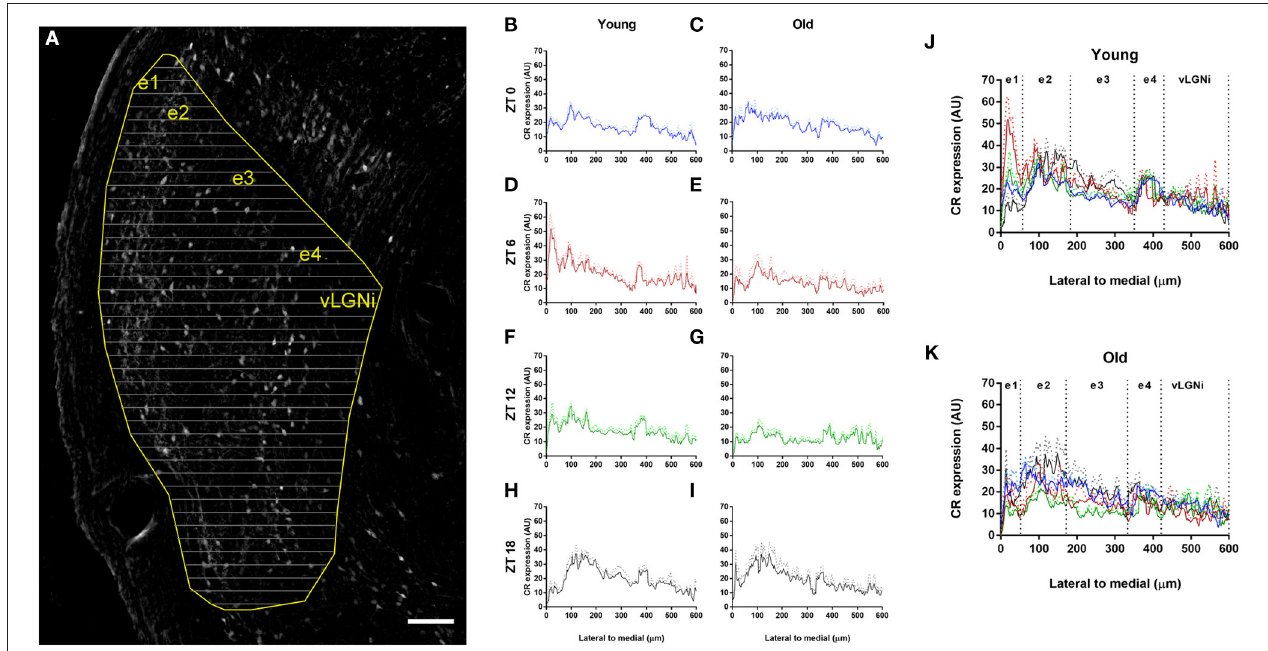
FIGURE 6 | Spatial distribution of CR staining in the vLGN. (A) Photomicrograph of the vLGN digitally processed for background subtraction. The vLGN borders are drawn (yellow) and equally spaced lines (gray) in the lateral to medial axis are overlaid to plot profiles of pixel intensity variations in arbitrary units (AU). Scale bar = 100 µ m. (B–I) CR staining levels through the lateral to medial axis in the young and old animals at t ZTs 0 (blue), 6 (red), 12 (green), and 18 (black). (J,K) Every ZT plot overlaid for the young and old animals. Relative CR predominance distinguishes five zones, namely, e1, e2, e3, e4, and vLGNi domains. Data are plotted as mean gray values with standard error for each